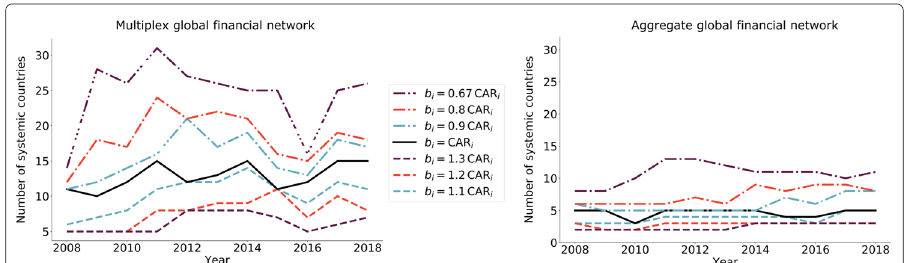
Fig. 6 Systemically important countries and horizontal thresholds. We show the number of systemically important (i.e., “systemic”) countries over time for different choices of the horizontal thresholds (i.e., capital buffers) in the (left) multiplex global financial network and (right) aggregate global financial network. The solid curve is for the baseline values b i = CAR i , the dot–dashed curves are for values that are below the baseline, and the dashed curves are for values that are above the baseline. The color of a curve indicates a specific choice of the